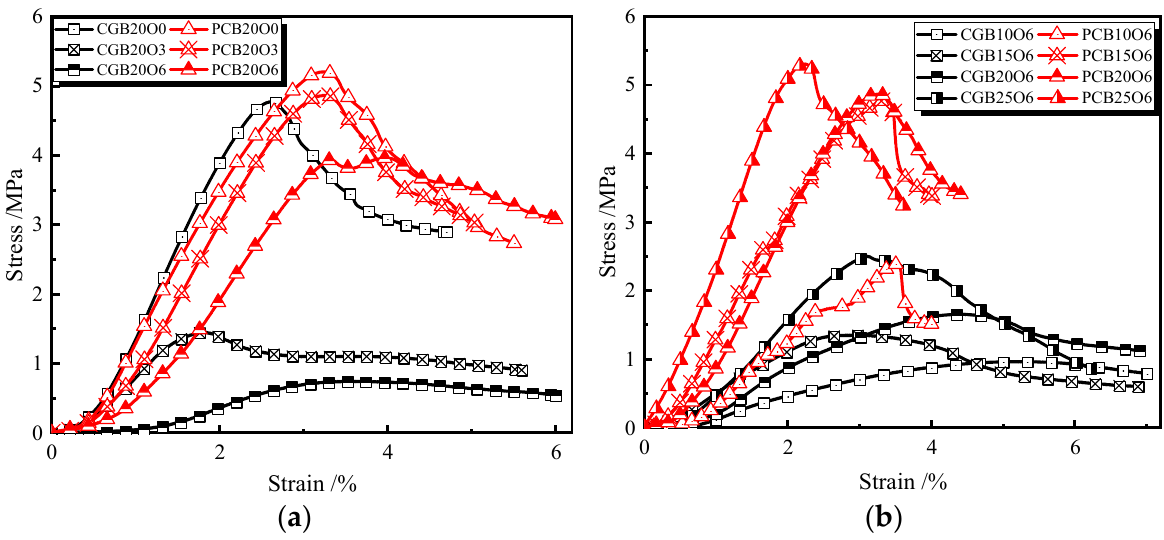
Figure 4. Stress–strain curves of CG/PC-stabilized specimens under different conditions. ( a ) Influ- ence of organic content (7 days). ( b ) Influence of binder content (28 days).